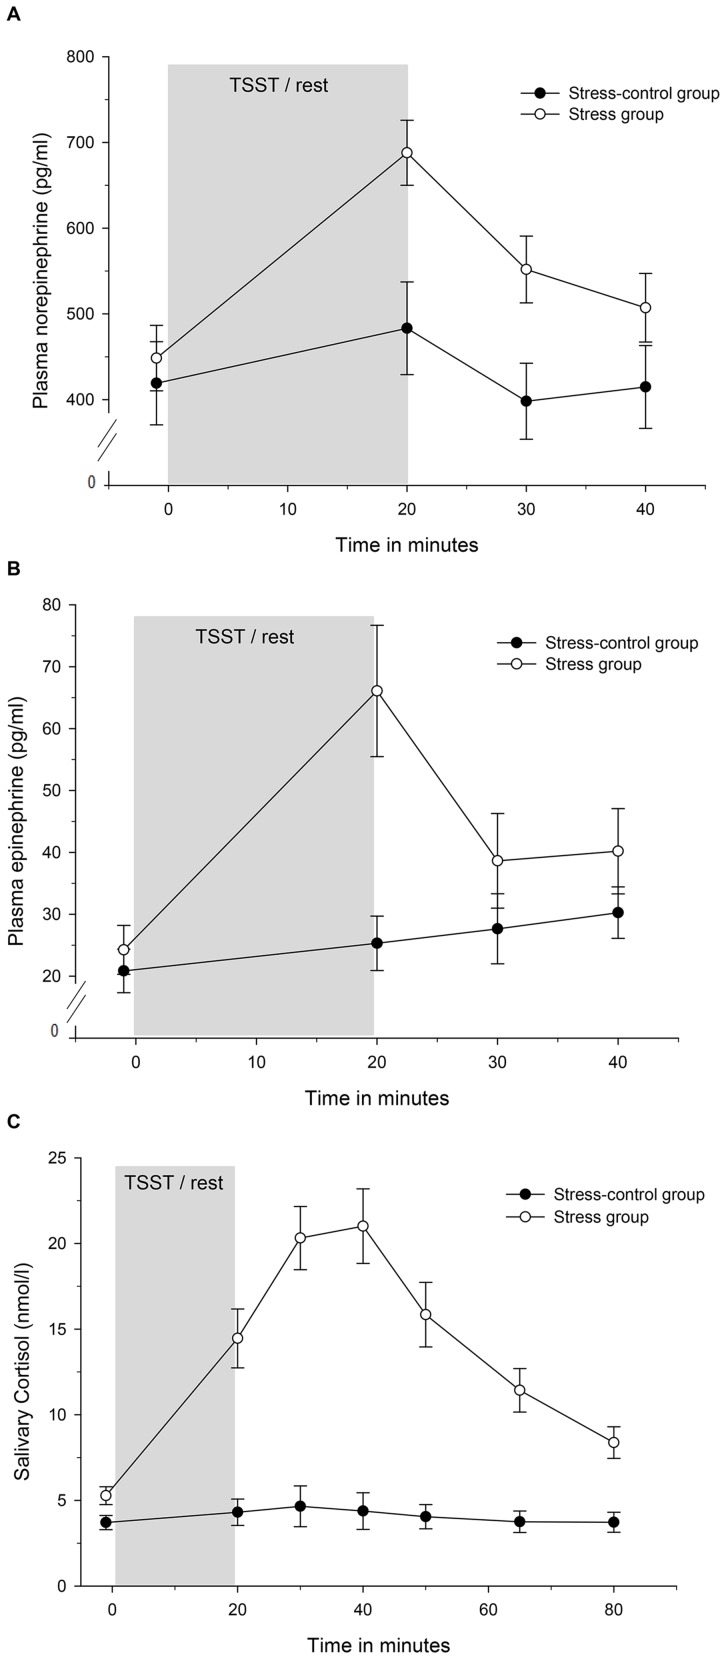
A to C. Course of norepinephrine, epinephrine, and cortisol over time in stress and stress-control group.Values are given as means ± SEM.